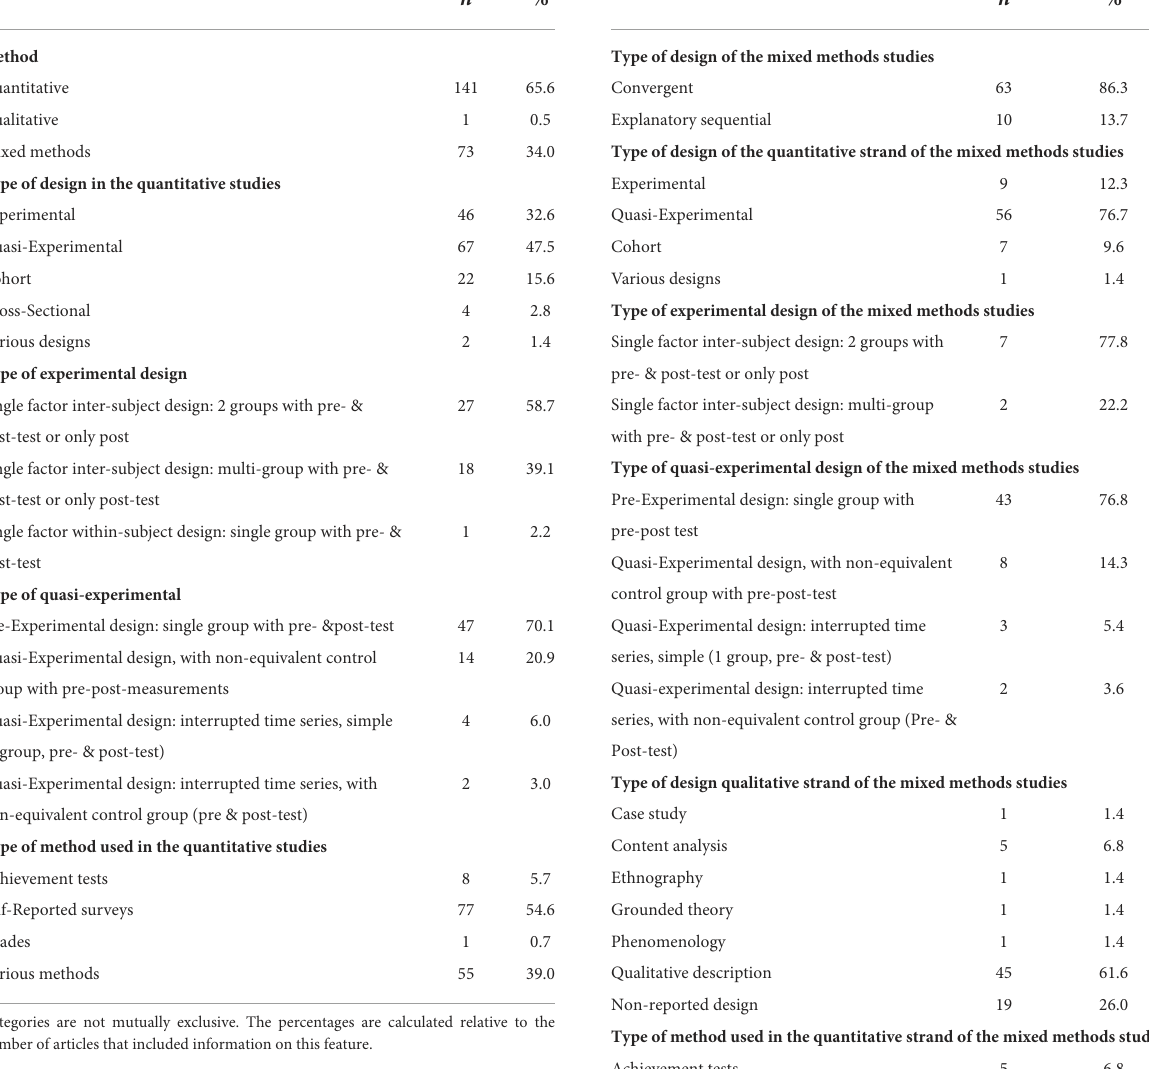
TABLE 5 Methodology of the intervention studies with a quantitative approach.